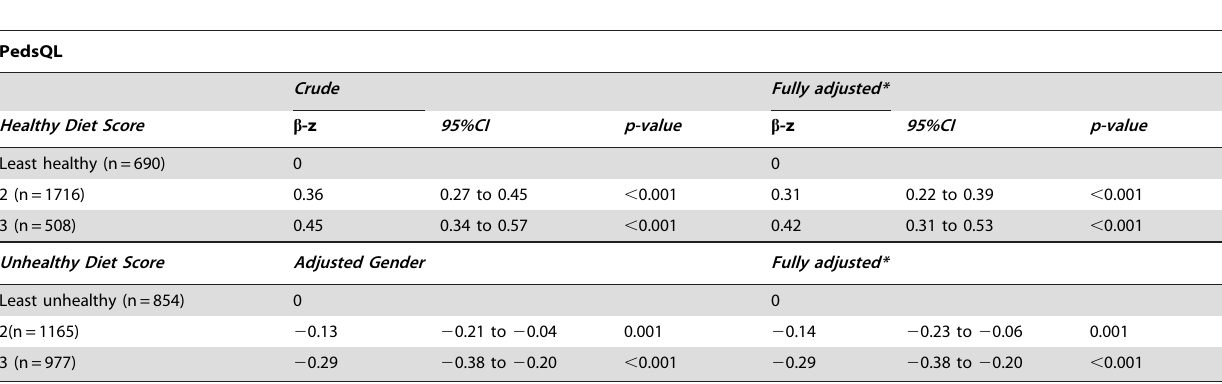
Table 2. Cross-sectional associations between diet quality and mental health at baseline: Results of multivariable linear regression